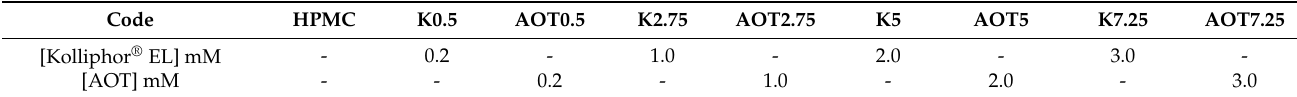
Table 1. Hydrogel composition and the corresponding codes. All hydrogels contained HPMC at 30 g · L − 1 , citric acid at 1.0 g · L − 1 and sodium hypophosphate at 0.5 g · L − 1 . The concentrations of Kolliphor ® EL and AOT varied from 0.2 mM to 3.0 mM. Code